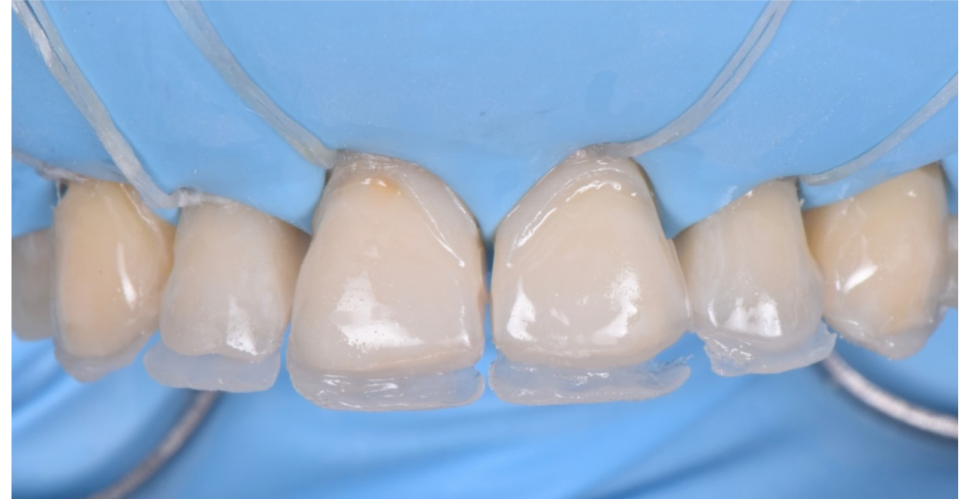
Figure 24. Enamel palatal shells following the “natural layering concept”.